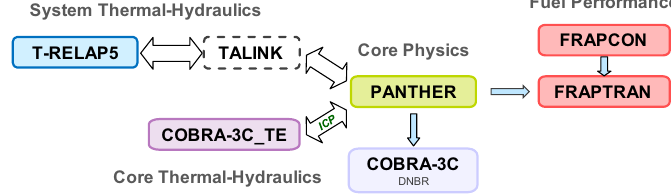
Figure 1. The TE multi-physics code